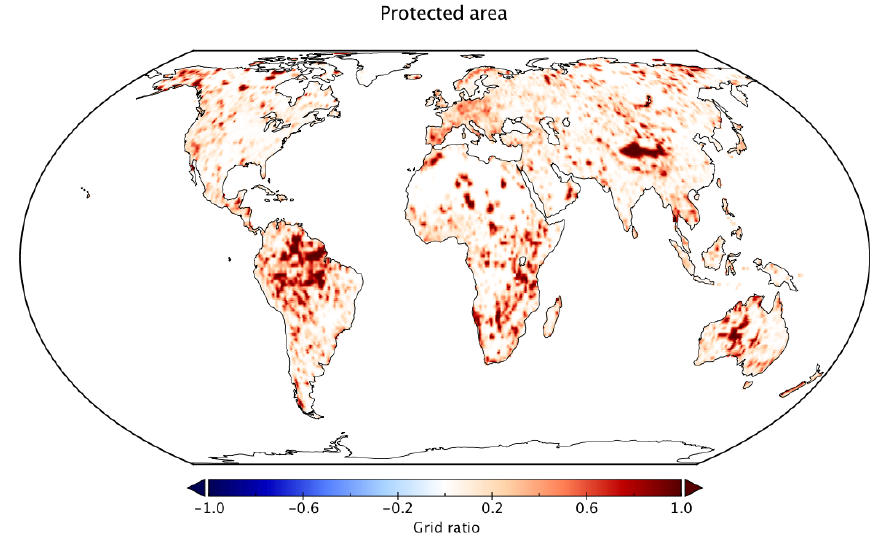
Figure B2. Global distribution of areas protected from bioenergy